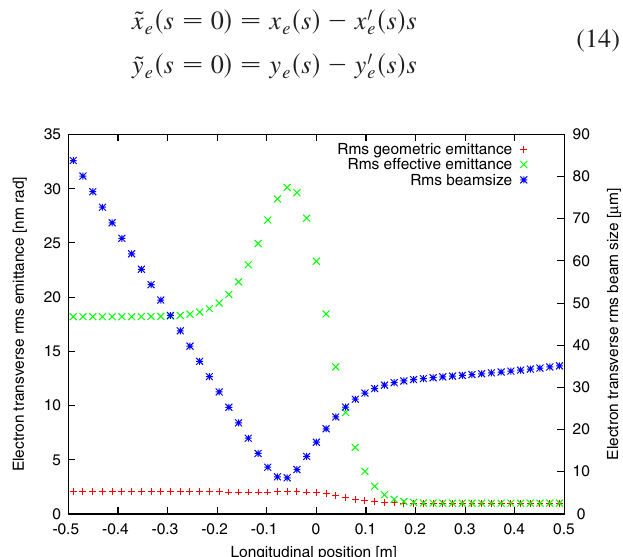
FIG. 3. (Color) Evolution of beam size and rms emittance (geo- metric and effective) of the electron beam for (cid:6) (cid:5) ¼ 1 m at s (cid:5) ¼ 0 m .